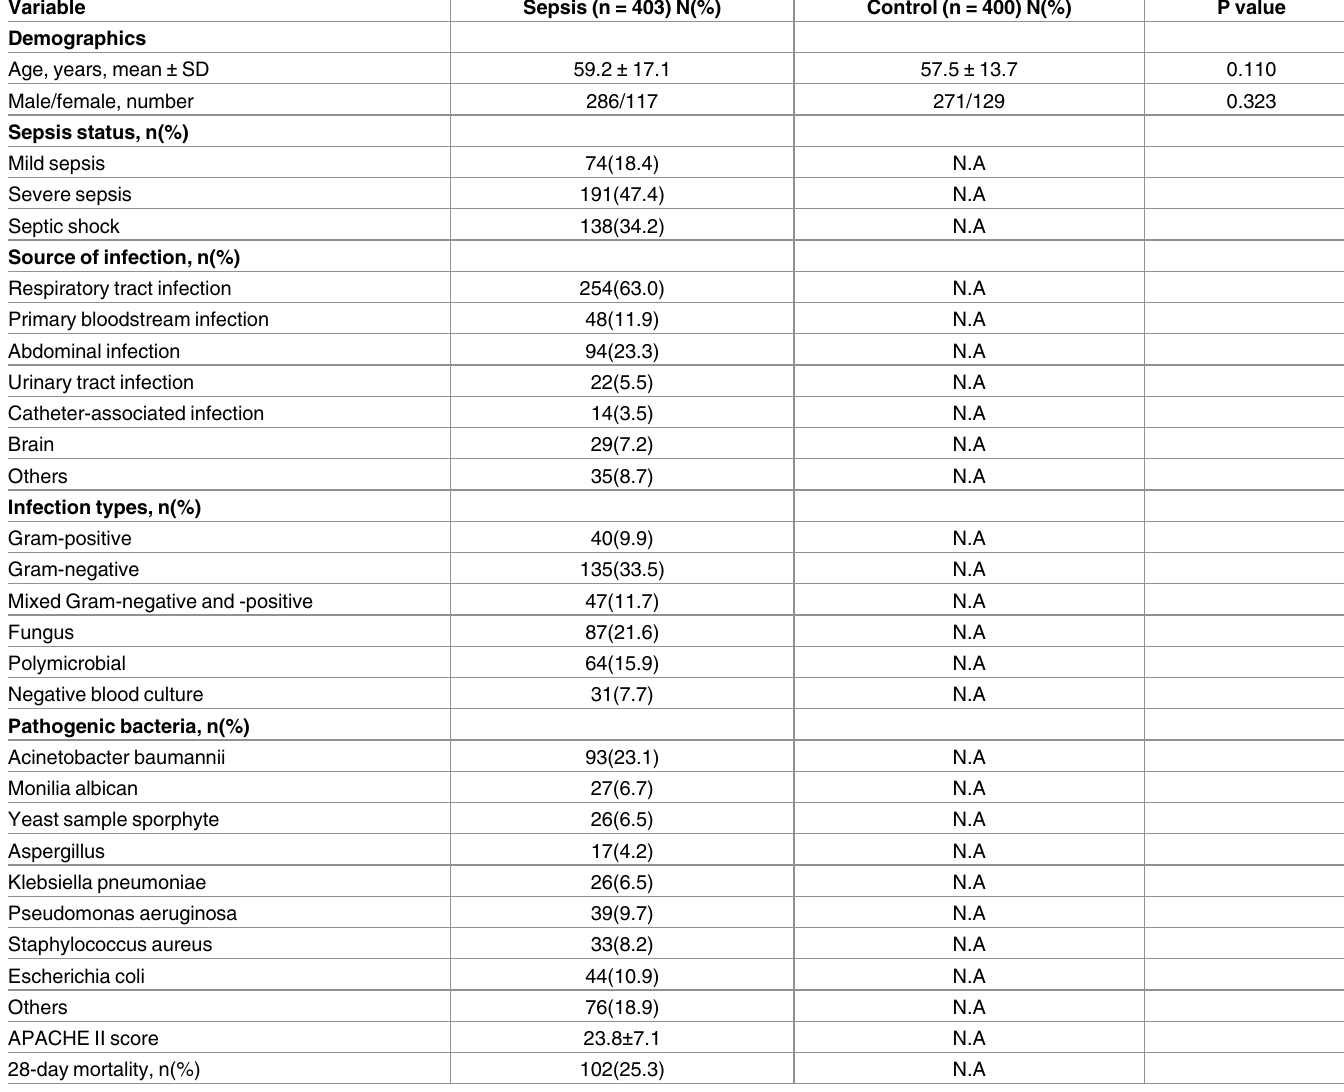
Table 1. Clinical characteristics of sepsis patients and healthy